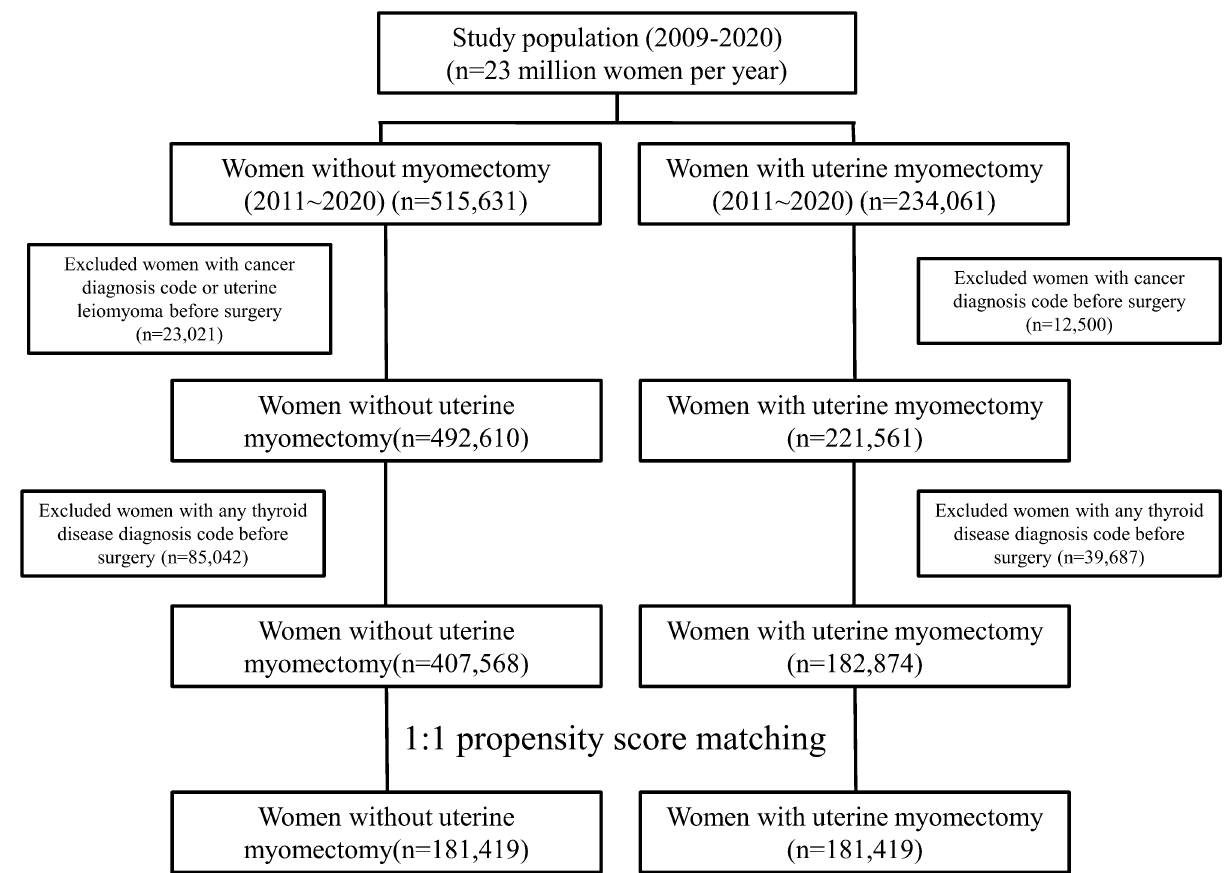
Figure 1. Flowchart for selecting case and control groups in this study using HIRA data. HIRA The Health Insurance Review and Assessment